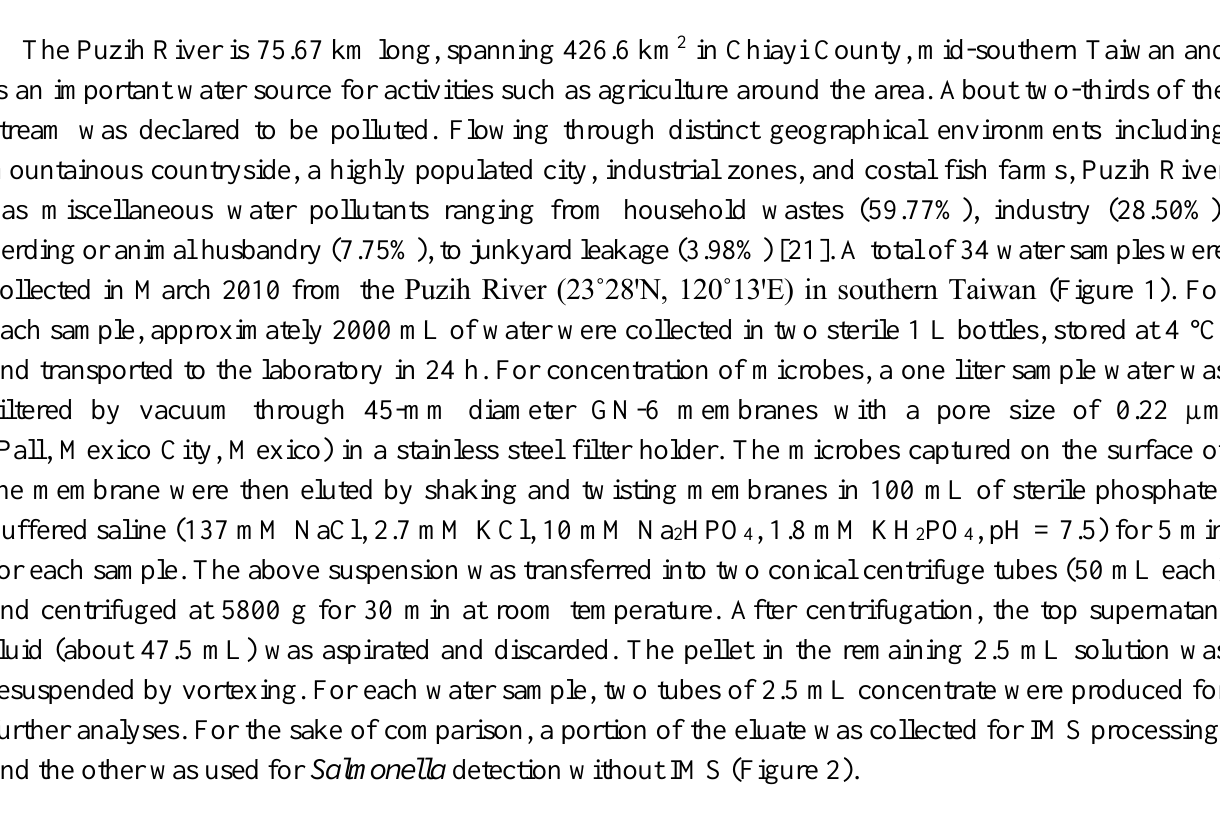
Figure 1. Sampling points along Puzih River. The sampling sites in the figure are shown as black dots